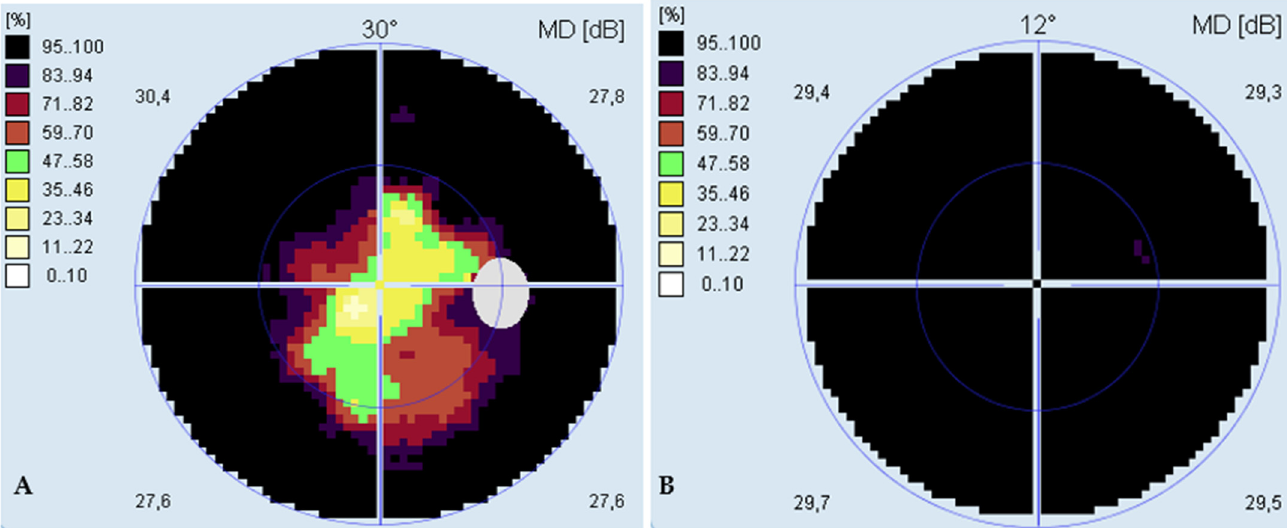
Figure 2. ( A ) SD-OCT image of the optic disc of the right eye; ( B ) SD-OCT image of the optic disc of the left eye.